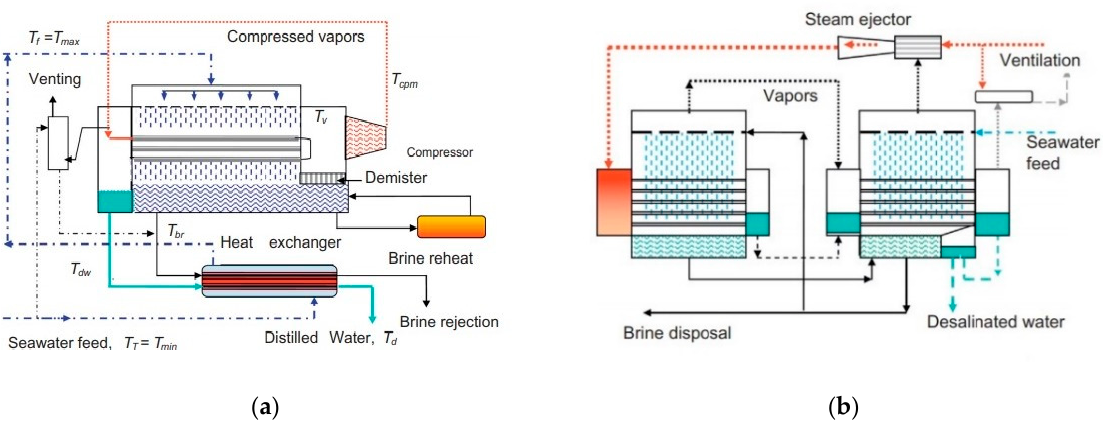
Figure 4. Schematic representation of the process: ( a ) MVC and ( b ) TVC. Source: Reproduced with permission from Ref. [33].